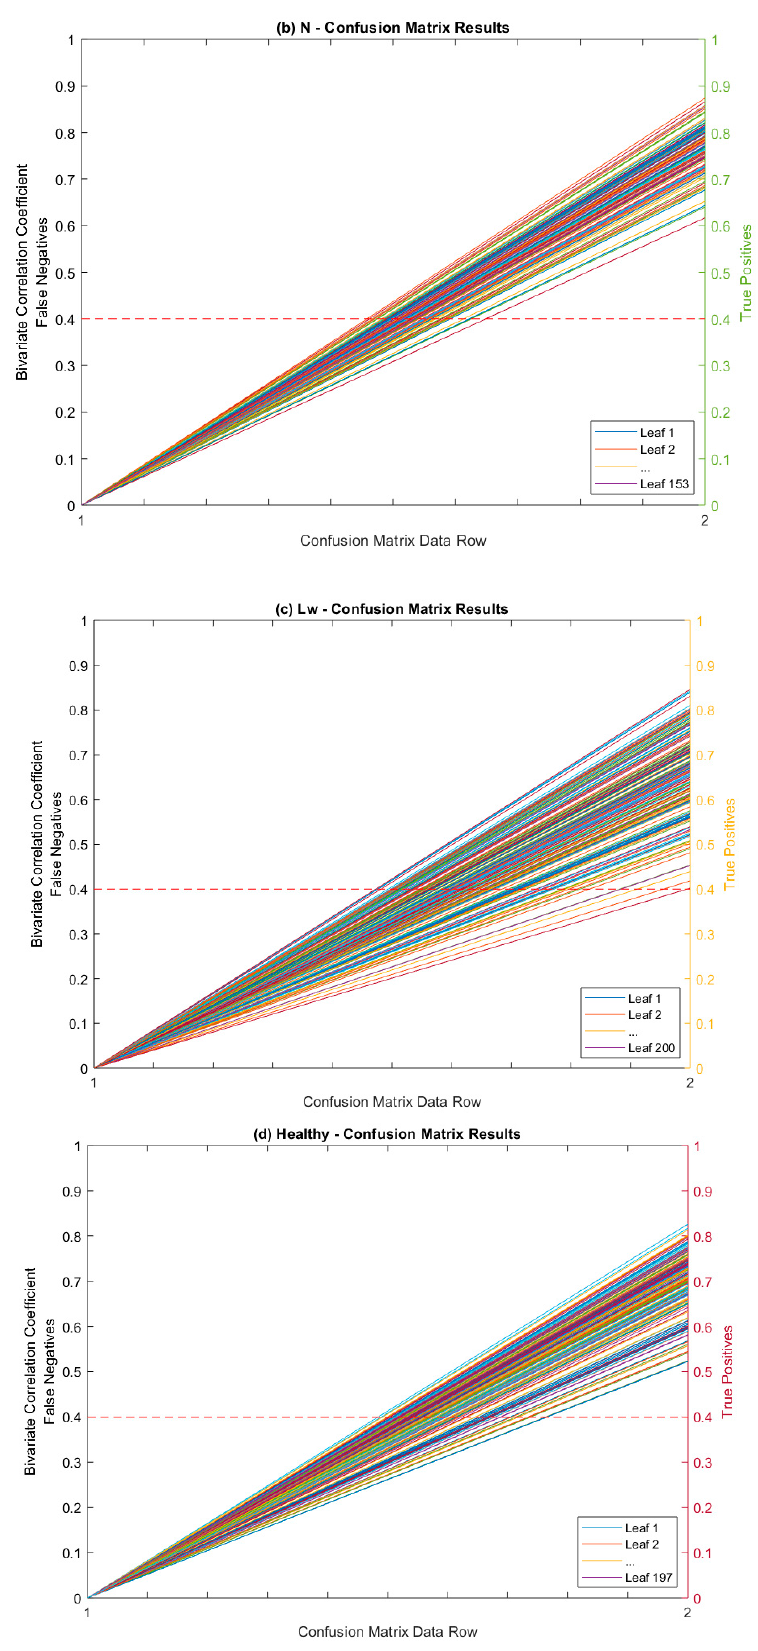
Figure 10. FDA-BC algorithm results of Confusion Figure 10. FDA ‐ BC algorithm results of Confusion Matrix. Table 2. Summary of Confusion Matrix; Accuracy: 100%.